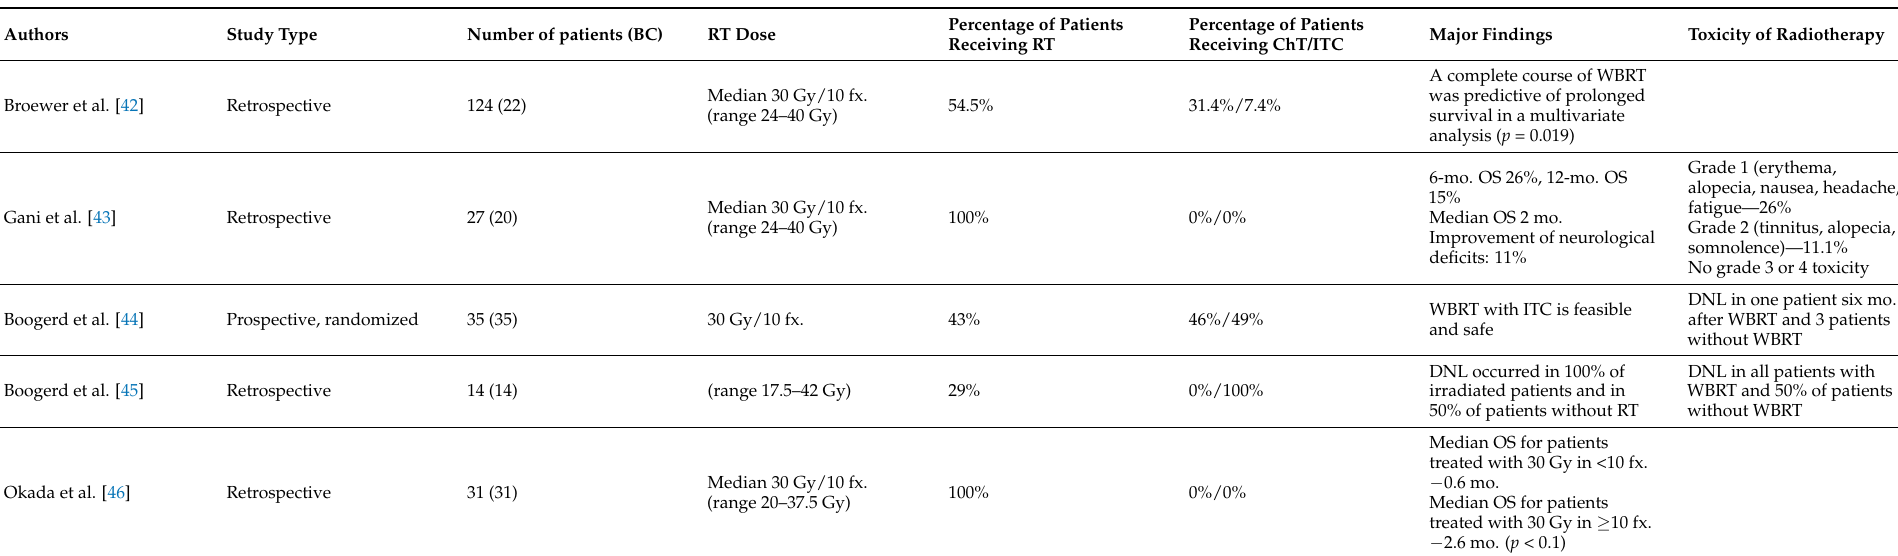
Table 2. Clinical studies evaluating the role of whole-brain irradiation for leptomeningeal carcinomatosis in breast